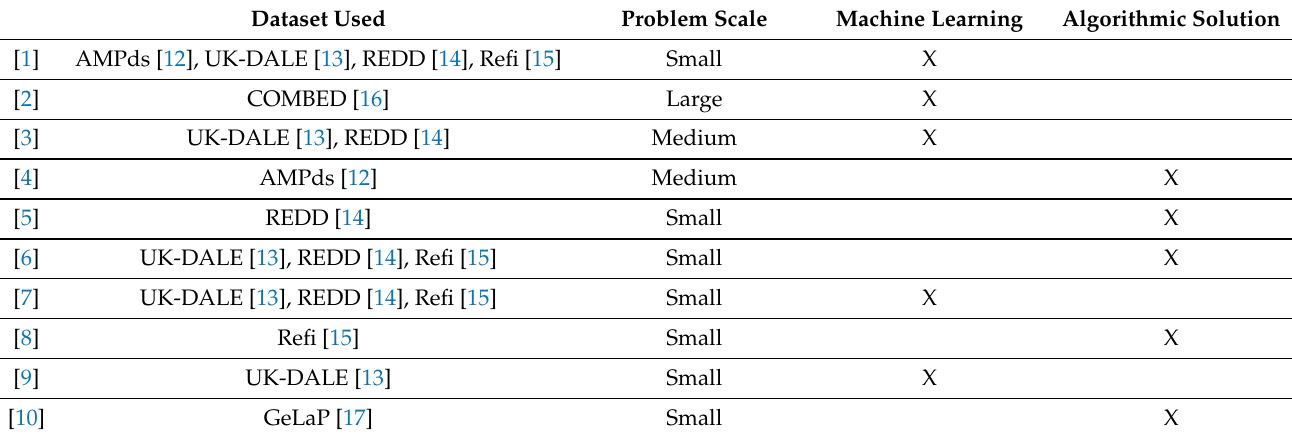
Table 1. Summary of the datasets used, problem scales, and the type of approach used in each paper. Dataset